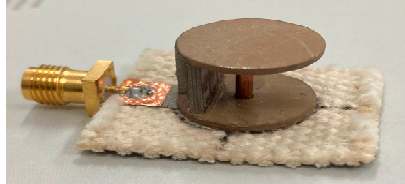
Figure 6. Antenna prototype.